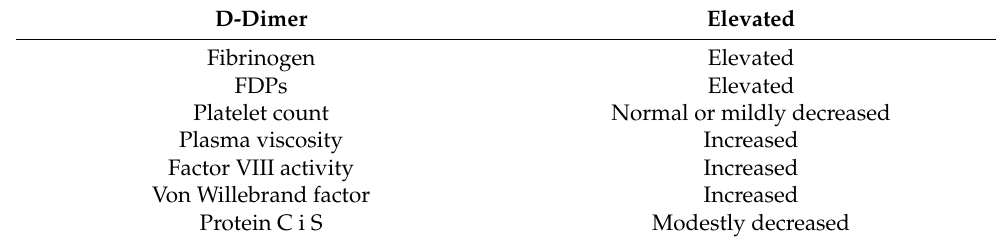
FPDs—Fibrinogen degradation